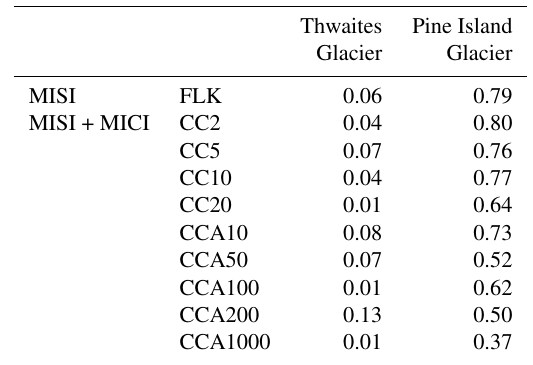
Table 4. Spearman correlation coefficients of determination be- tween bed depth and grounding-line retreat